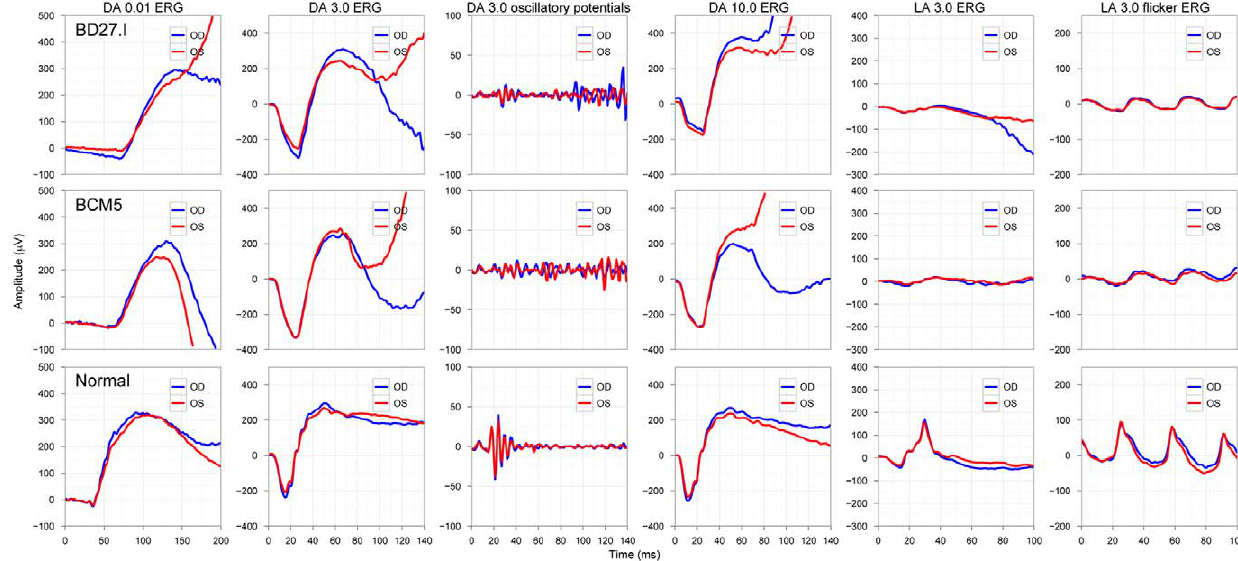
Figure 3. ISCEV standard Ganzfeld ERG responses of a representative patient of each group compared to a normal subject. Patient BD27.I in the upper panels represents the NOP group, while the result of patient BCM5 in the middle panels is an example for the ALP group. The normal subject is represented in the bottom panels. The patients’ findings show the characteristic features of the scotopic ERG (dark-adapted (DA)) and the small photopic responses (light adapted (LA). Notice the missing oscillatory potentials on the rising b-wave in patients. (Color coding in each panel: red curves show results of the right eye (OD), blue curves show results of the left eye (OS)).